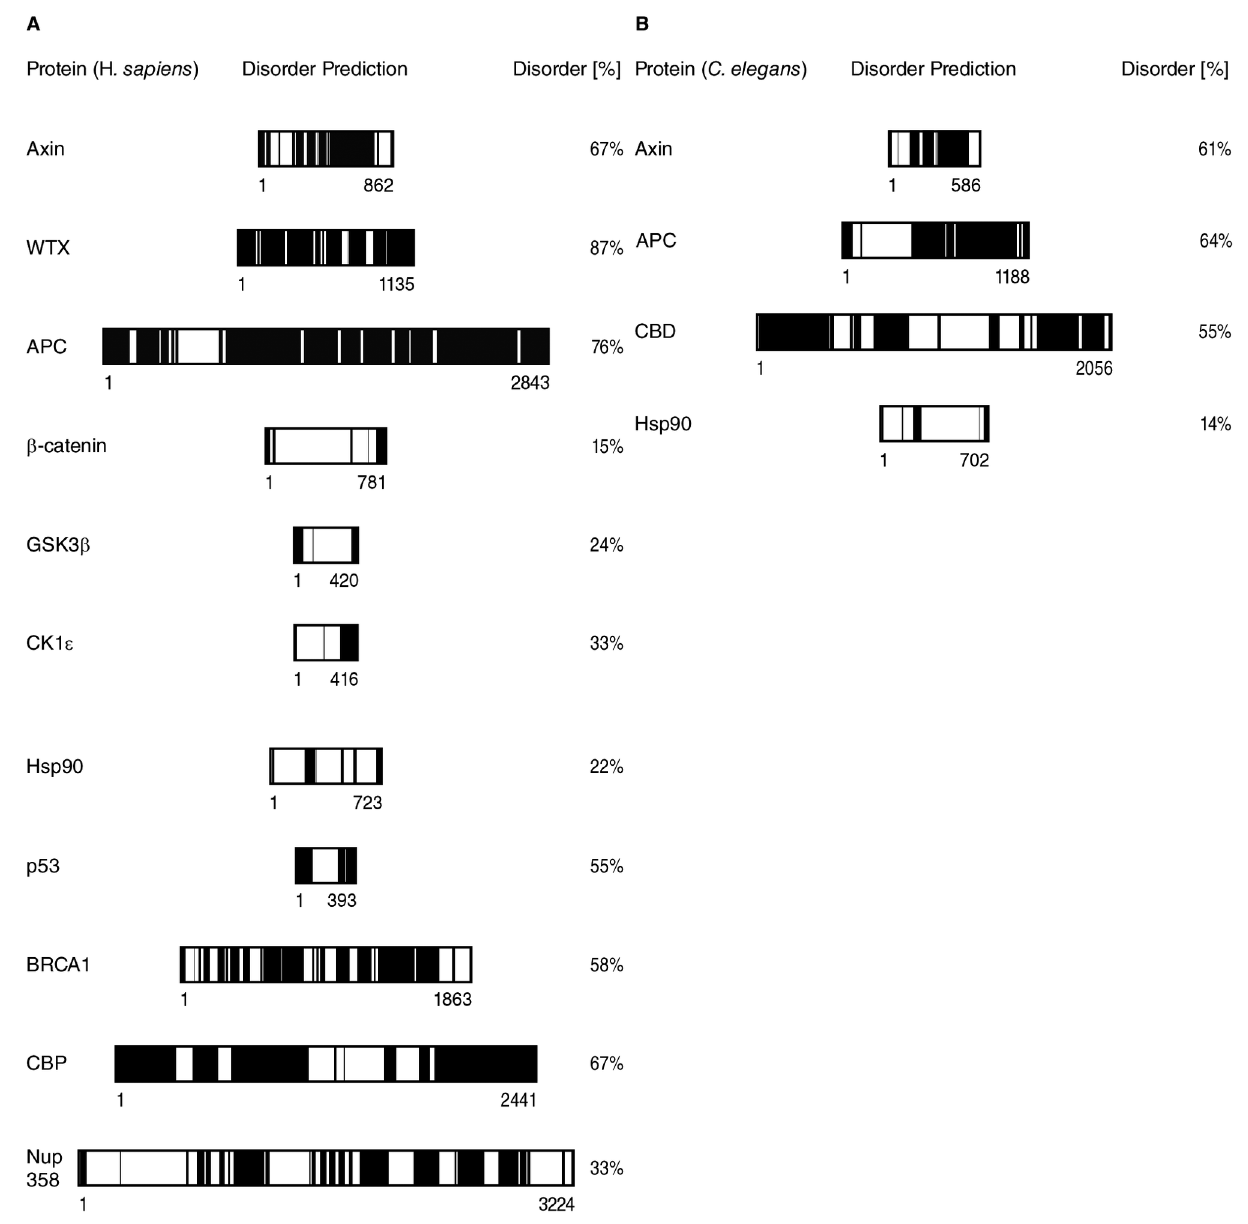
Figure 7. The three Wnt signalling hubs APC, Axin, WTX contain large intrinsically disordered regions. A , Meta-predictions of disorder using the PONDR-FIT algorithm are displayed. (black for scores >= 0.5 and white for scores < 0.5). B , Same as A, for C. elegans homologues of APC, Axin, Hsp90, CBP. doi: patients [18]. The combination of a redundant set of binding sites for interactors and extended intrinsic disorder and presence of multiple potential phosphorylation sites might be crucial to protect Wnt signalling fidelity against mutational impact.